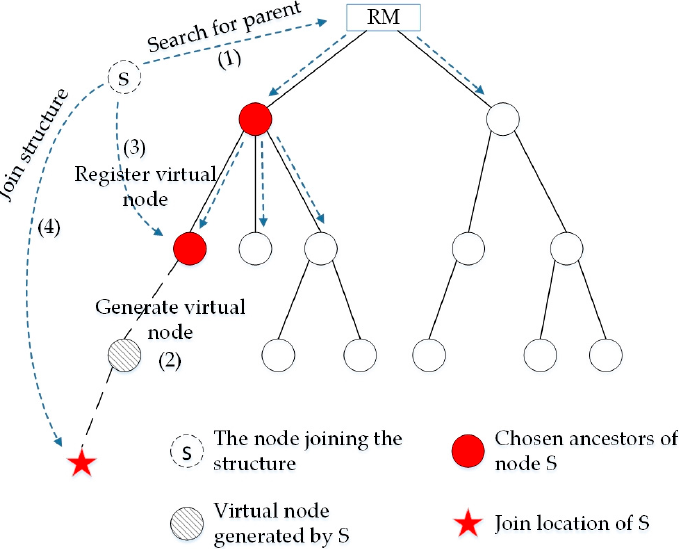
Figure 5. Node-joining process. Algorithm 1 Node Joining